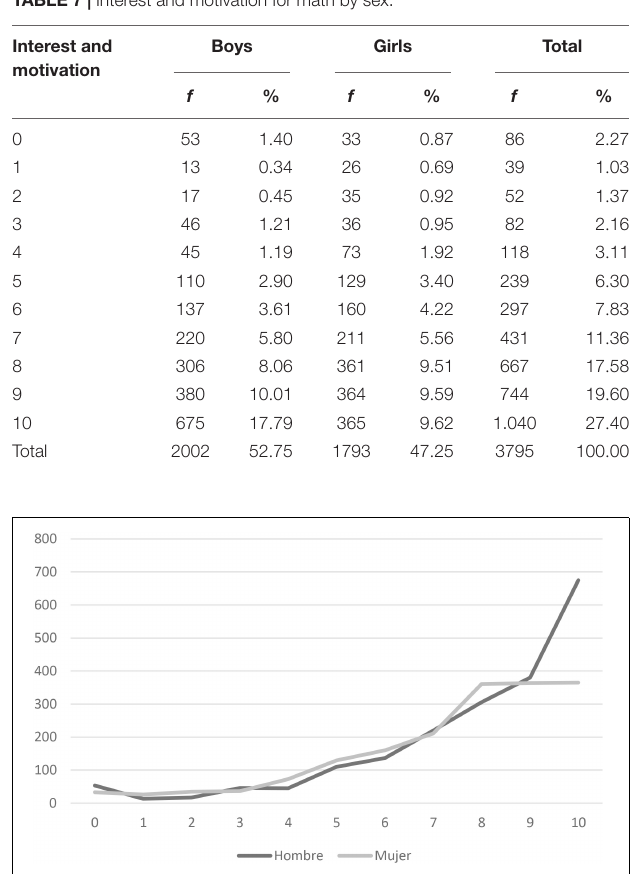
FIGURE 2 | Graphical representation of sex-differences in interest and motivation for math.